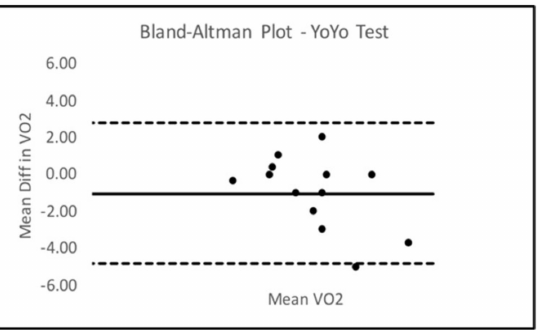
Figure 6. Bland–Altman Plot YoYo